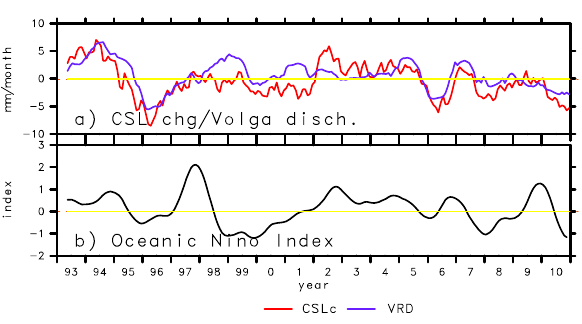
Fig. 1. Time series of monthly mean anomalies, i.e. with the mean annual cycle removed, for a selection of variables. A three month running mean has been applied for smoothing. (a) precipitation over the VB using ERA and GPCC (moni=GPCC monitoring product, GPCC = final product) data, (b) evaporation over the VB, (c) 2m temperatures averaged for the VB, (d) evaporation over the CS it- self, (e) observed Volga River discharge and (f) CSL. Note that the CSL values are centred on the first of each month while the other quantities are monthly means.